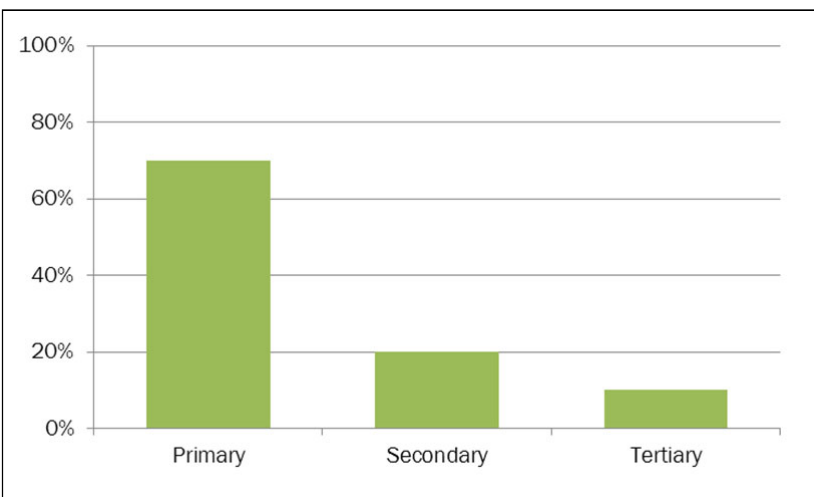
Figure 2. Educational Levels of Urban Farmers (N=30)